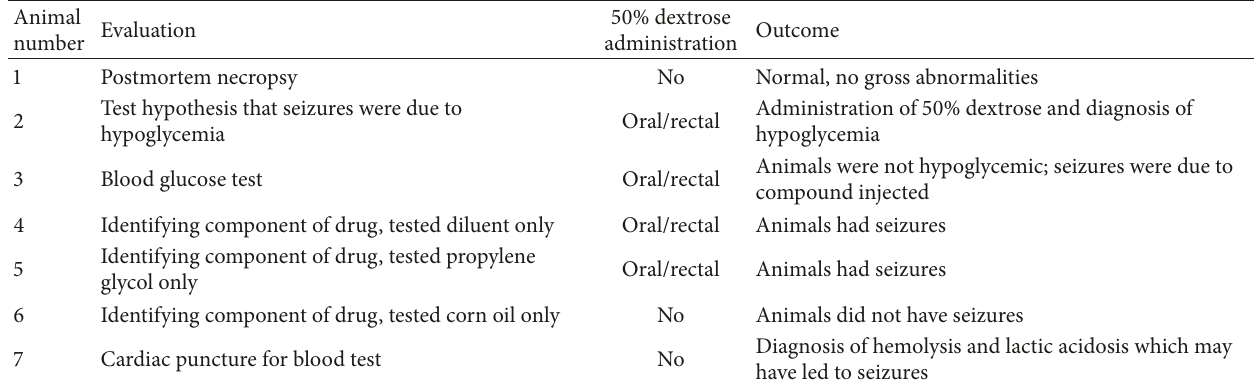
Table 1: Summary of animals described within the case